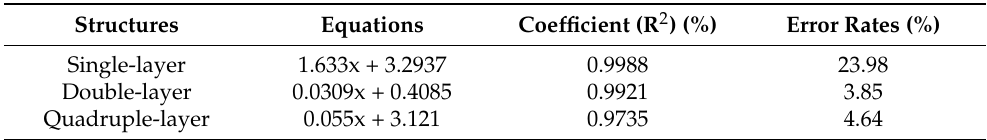
Table 1. Piezoresistive textile pressure sensor calibration.